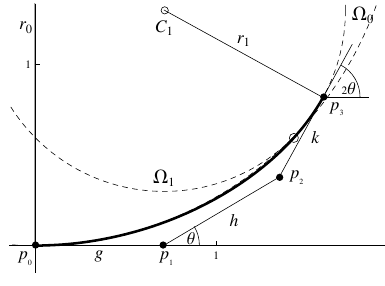
Figure 1. A C-shaped transition curve in normalized